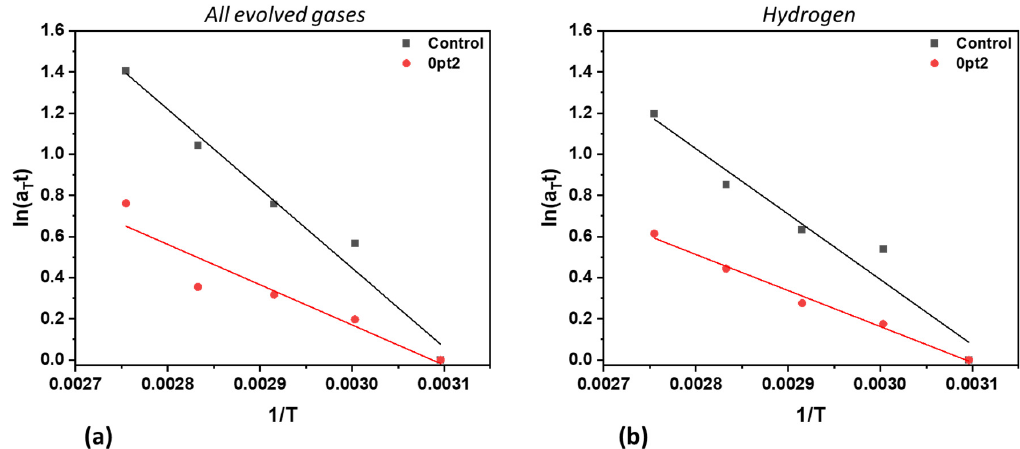
display a linear relationship for T